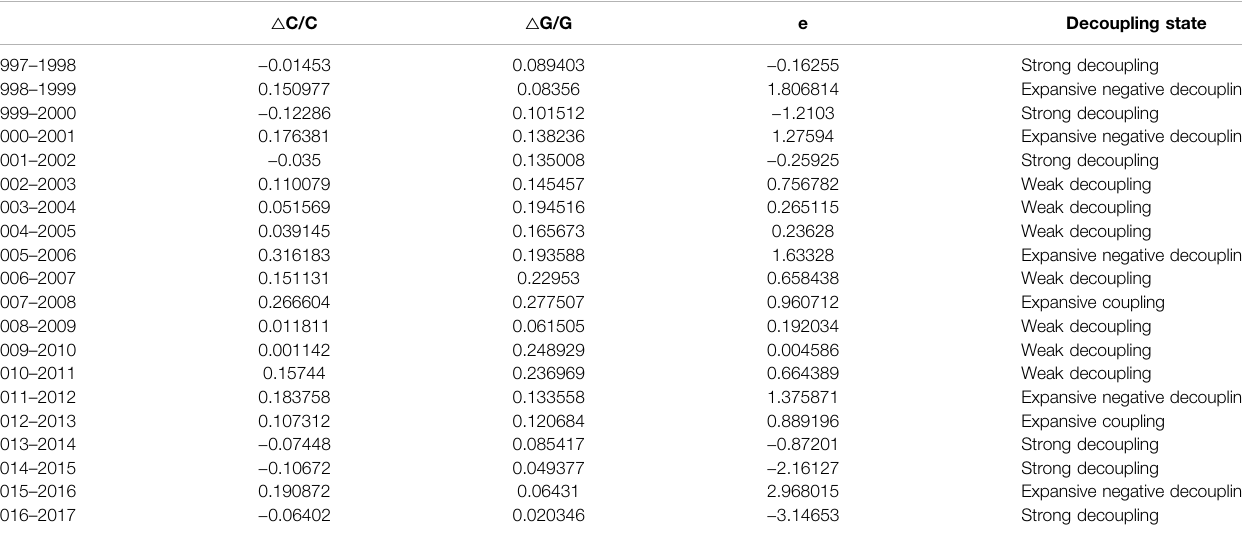
TABLE 3 | The decoupling state for Qinghai over 1997 – 2017. △ C/C △ G/G e Decoupling